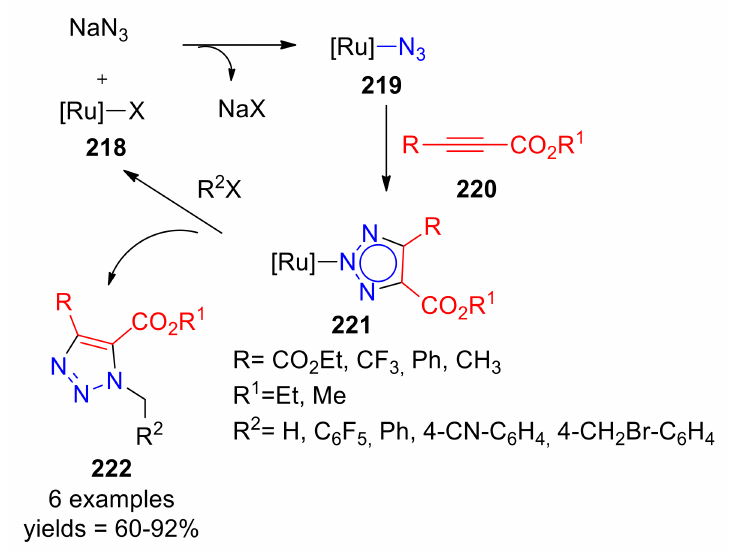
Scheme 71. Synthesis of 1,4,5-trisubstituted triazoles by a 3 + 2 cycloaddition using different ynoate esters. In 2017, Gribanov and co-workers [126] described a Suzuki–Miyaura cross-coupling of 4- or 5-halo-1,2,3-triazoles with arylboronic acids in water to obtain different 1,4,5- trisubstituted-1,2,3-triazoles 226 and 227 with an expanded-ring N -heterocyclic carbine palladium complex as catalyst 228 (Scheme 72). The products were obtained in high yields using 4-bromo-1,2,3-triazoles with an aromatic and benzylic substituent on the nitrogen.